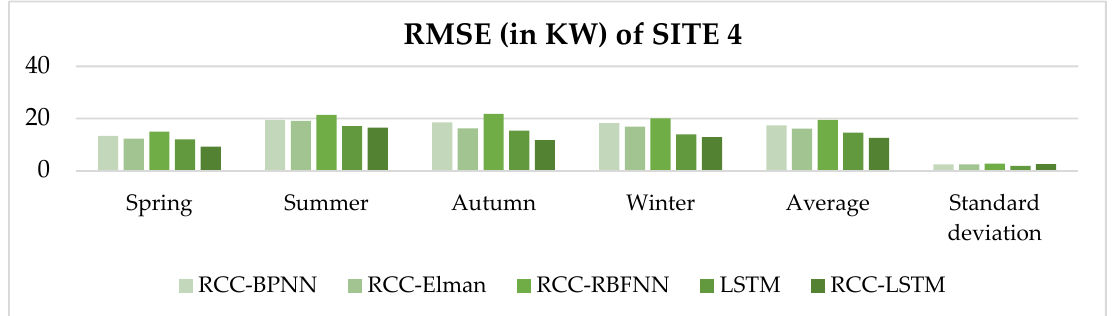
Figure 14. Comparative MAPE (in %) results of SITE 4. Figures 15 and 16 show the MAE results of two PV systems, in SITE 3A, the presented model’s average MAE improvement relative to the compared four models is 27.30%, 23.15%, 41.93%, and 9.34%, respectively. In SITE 4, the presented model’s average MAE improvement relative to the compared four models is 45.29%, 32.10%, 53.83%, and 19.06%, respectively. Figure 15. Comparative MAE (in KW) results of SITE 3A.